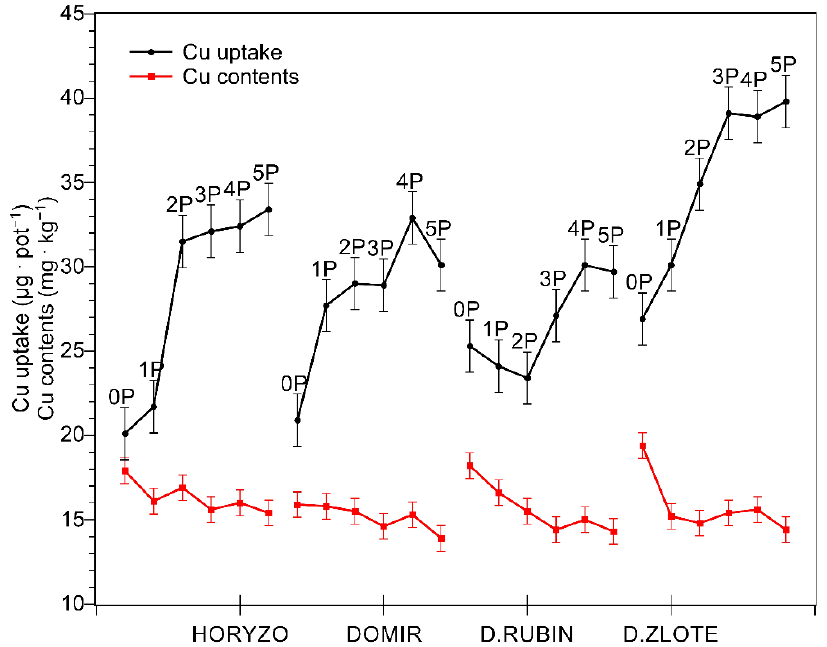
Figure 1. Changes in the copper (Cu) uptake and concentration in shoots of rye varieties grown on the post-flotation sediment. Plants were supplemented with 0 (0P), 22 (1P), 44 (2P), 66 (3P), 88 (4P), and 110 (5P) mg P·kg − 1 . The shoot tissue samples were collected 28 DAS at the BBCH 12 stage, dried, and used for determining Cu concentrations. Data represent the means of n = 9 replications, and vertical bars represent 95% confidence intervals after a post hoc Tukey HSD test (interaction P dose × variety), with the letters denoting homogeneous groups being omitted for a clear view.